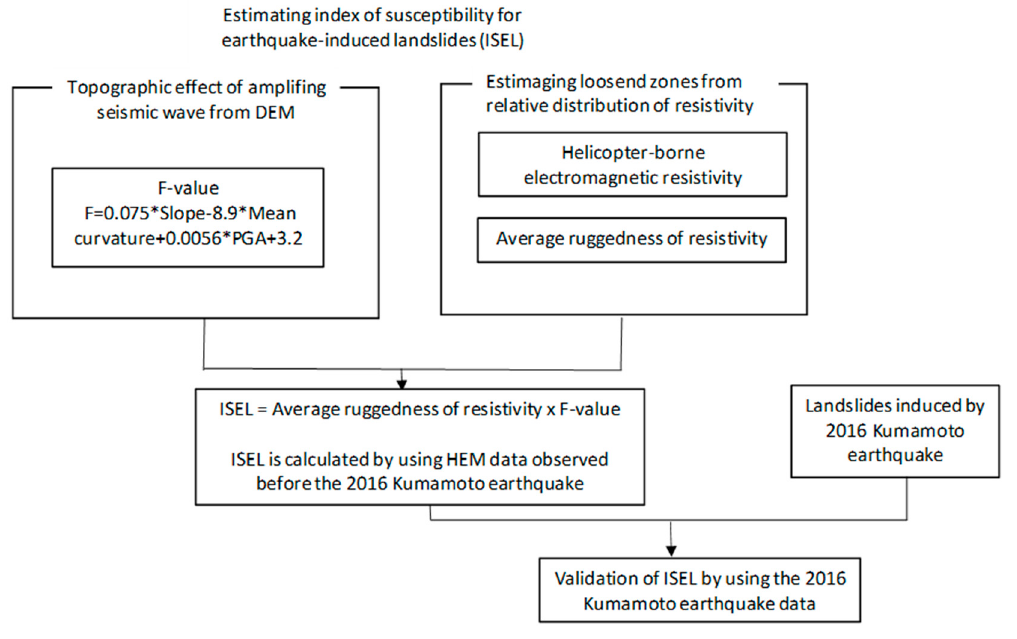
Figure 4. Flow diagram of this study.